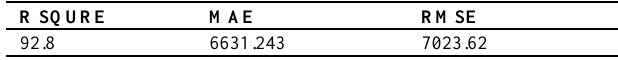
Table 9. The obtained error values in regression method using the factors in previous studies.